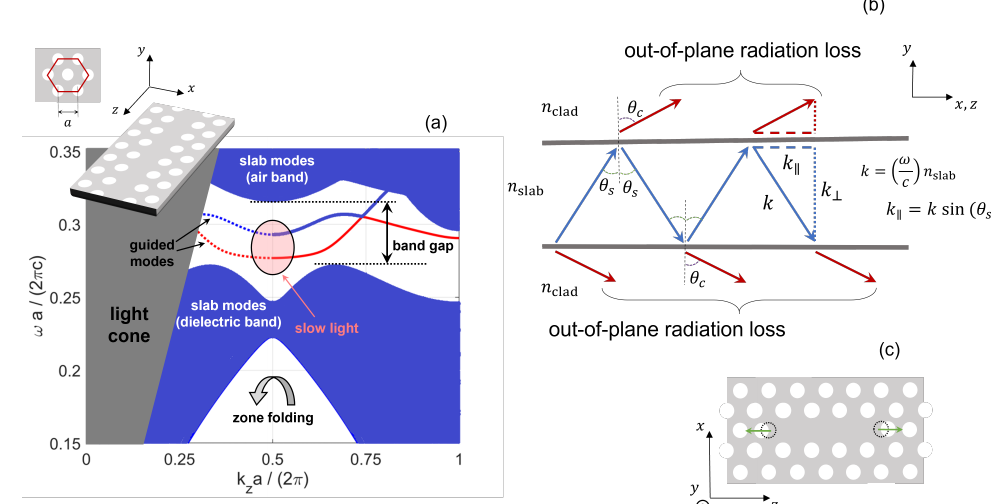
Figure 2. ( a ) A dispersion diagram of TE-like modes of a line-defect waveguide in a photonic crystal membrane, as depicted in the inset. The y -axis shows the angular frequency, ω , normalized to 2 π c / a , with c being the light speed in vacuum and a the lattice constant. The x -axis shows the wavevector along the propagation direction, k z , normalized to 2 π / a . Modes in the gray area (the so-called light cone) are not confined by total internal reflection in the membrane. Details on the simulation parameters are provided in Section 4.1. ( b ) A ray-optics illustration within the light cone of the reflection and transmission at the interface between semiconductor slab and air cladding. ( c ) Optimization of a line-defect cavity by displacement of the holes at the edges of the cavity. The hole shift reduces the out-of-place radiation